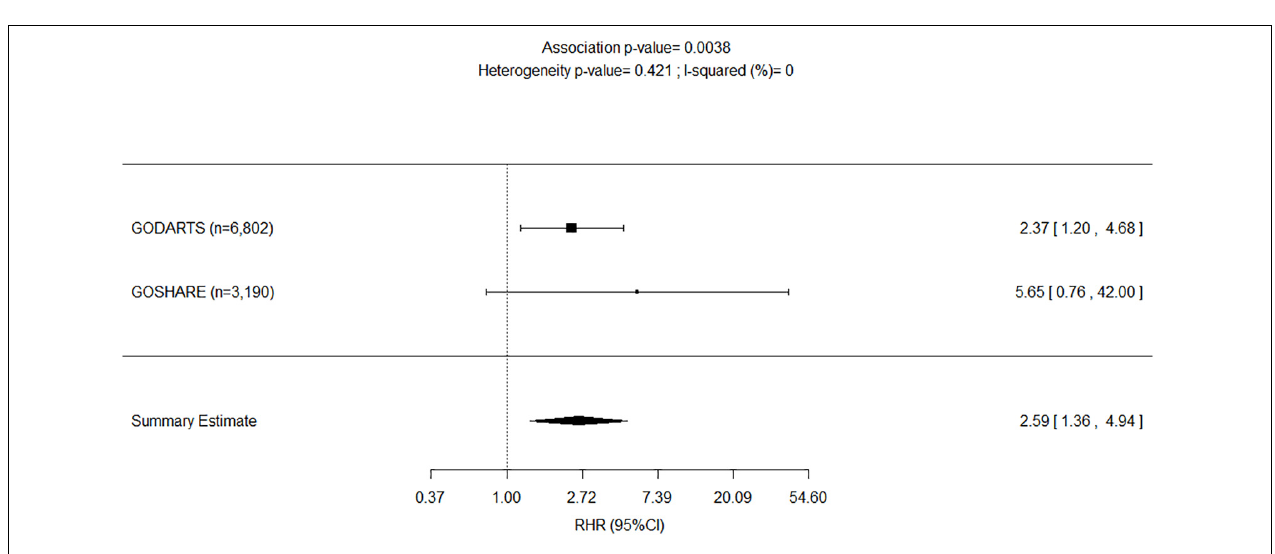
FIGURE 4 | Forest plot for meta-analyses of pharmacogenetics interaction between exposure to L-thyroxine and INSR -rs4804416 on developing atrial fibrillation within 10 years of follow-up. RHR, Ratio of hazard ratios.